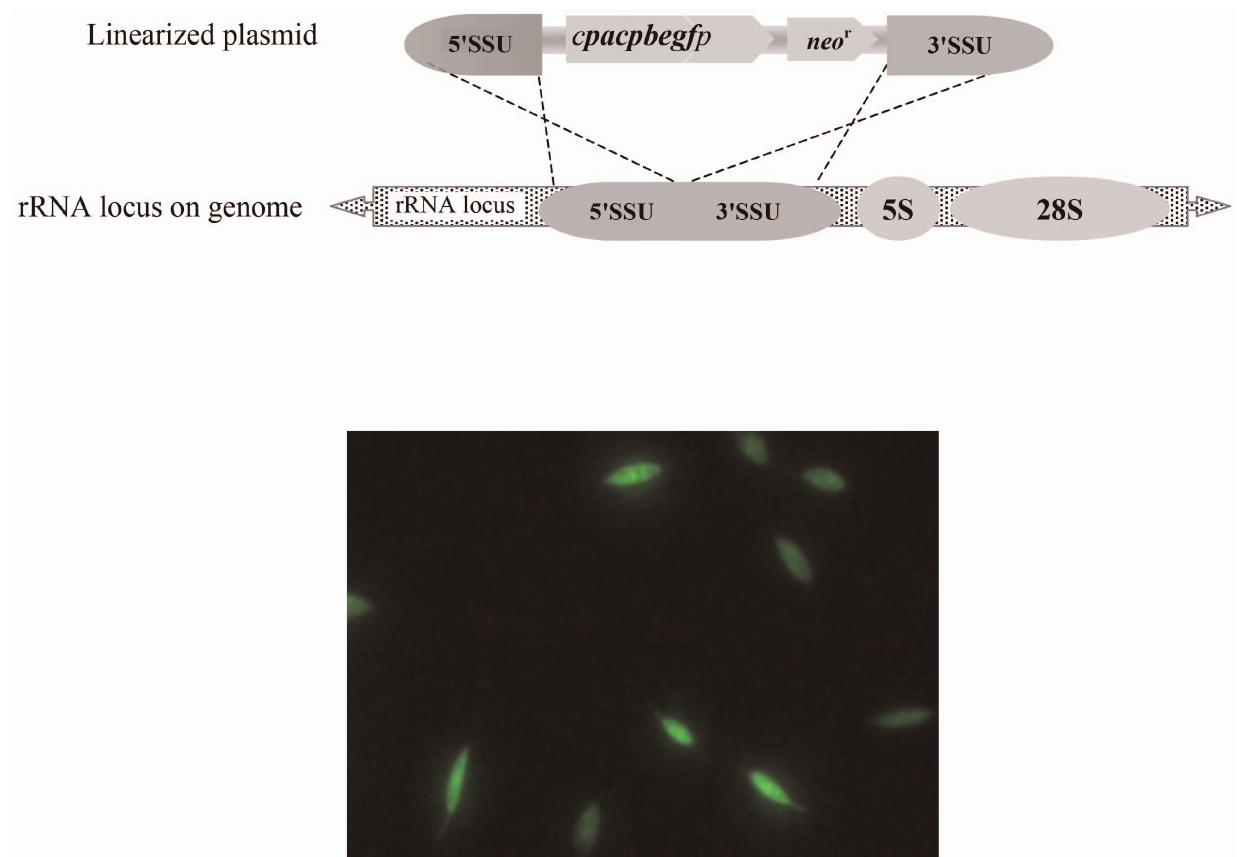
Figure 1. Schematic structure of the 5 9 SSU- CPA/CPB/EGFP -3 9 SSU cassette linearized with Swa I to integrate it into the SSU region of the L.major genome (A). Microscopic analysis of L. tarentolae stably expressing CPA/CPB/EGFP into the ribosomal locus (B).